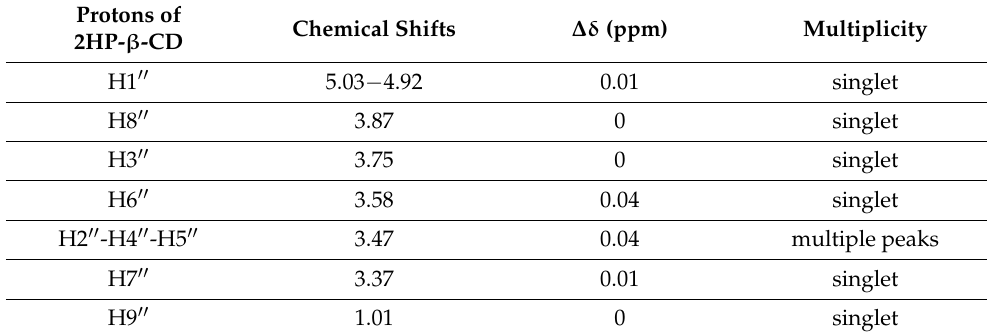
Figure 3. The 1 H NMR of ( A ) 2HP- β -CD ( B ) complex of QUE with 2HP- β -CD. The spectra were obtained at 25 °C in D 2 O. Table 3. 1 H NMR chemical shifts for 2HP- β -CD and the lyophilized complex, in D 2 O at 25 °C.